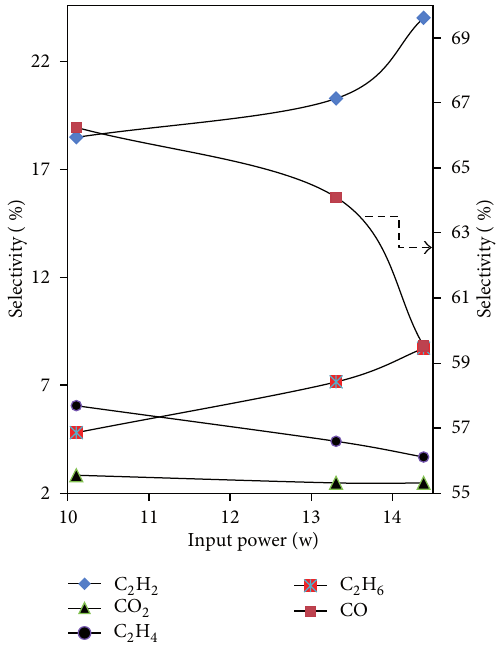
F 6: Selectivity of products versus power applied to the reactor over combined Ni-ZSM5 catalyst and gas discharge plasma.